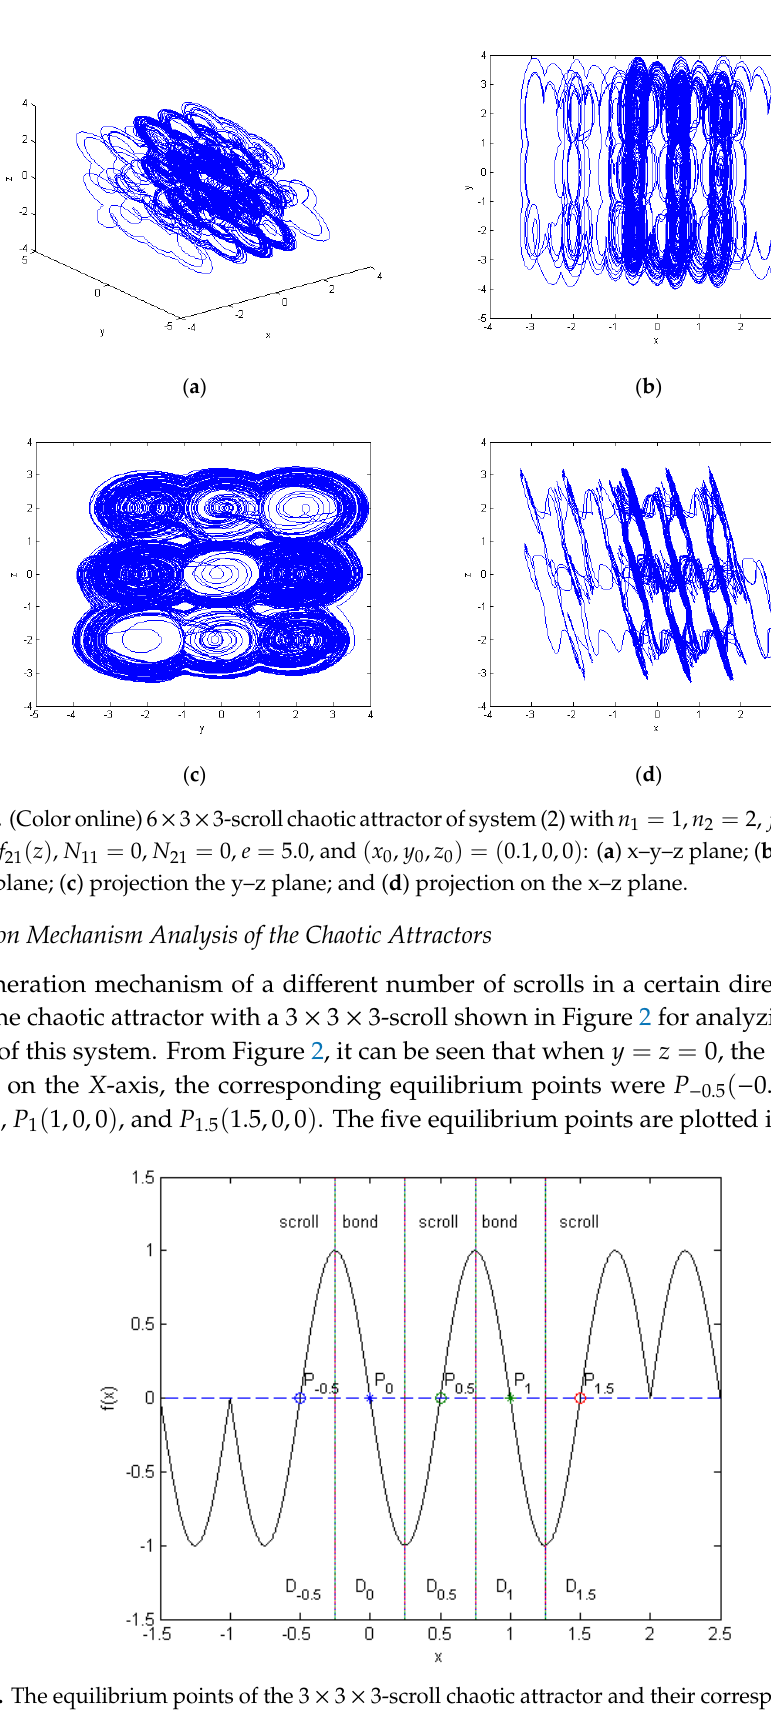
Figure 8. The equilibrium points of the 3 × 3 × 3-scroll chaotic attractor and their corresponding region.